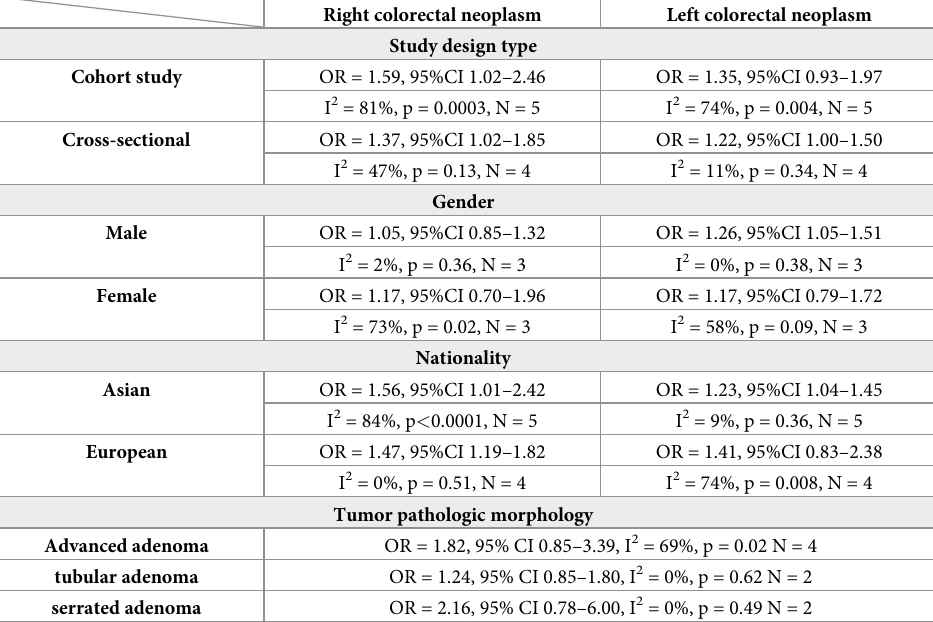
Table 2. Sensitivity and subgroup analyses about the association between NAFLD and the risk of right and left- side colorectal